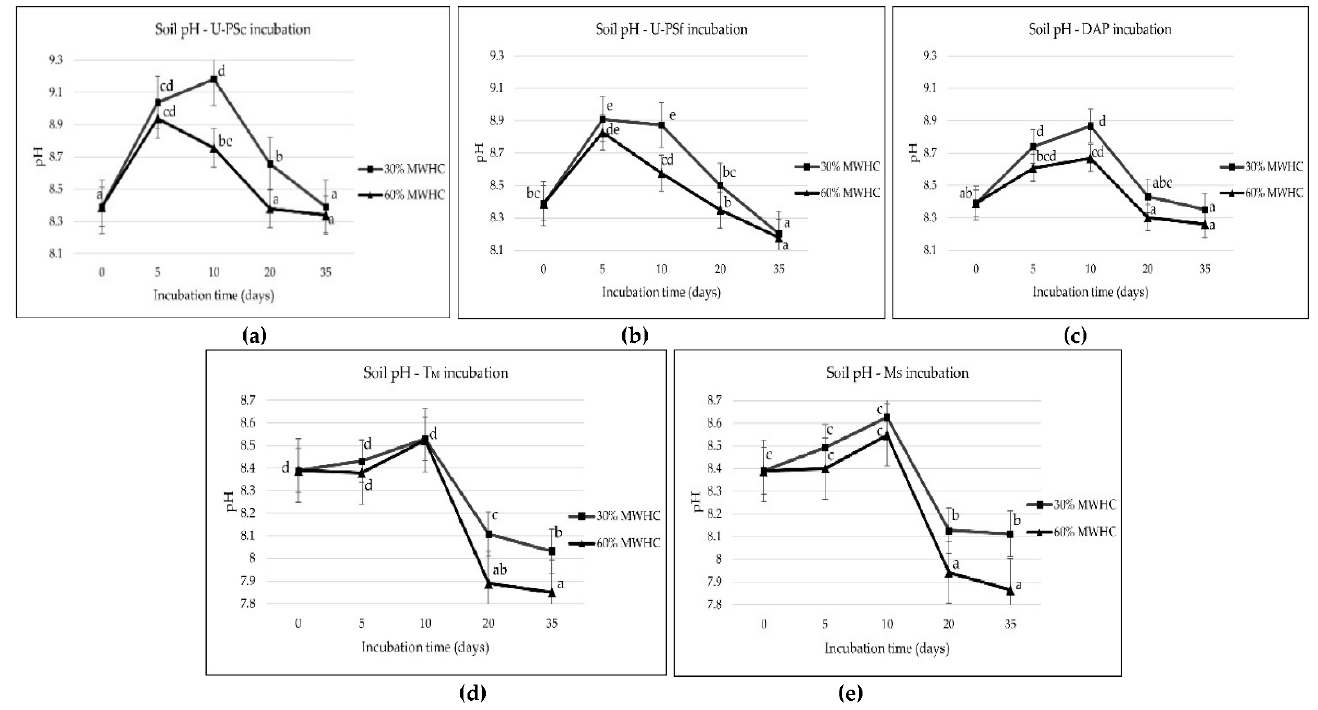
Figure 5. Effect of incubation time and soil moisture on soil pH under incubation of mineral ( a – c a; b; c; a; b; c; a; b; c; ) and organic ( d , e ) fertilizers; values are mean ± standard error; small letters indicate significant difference from one another based on Tukey’s test at p < 0.05 (the pH value was converted into the concentration of hydrogen ions, then statistical analysis was performed).